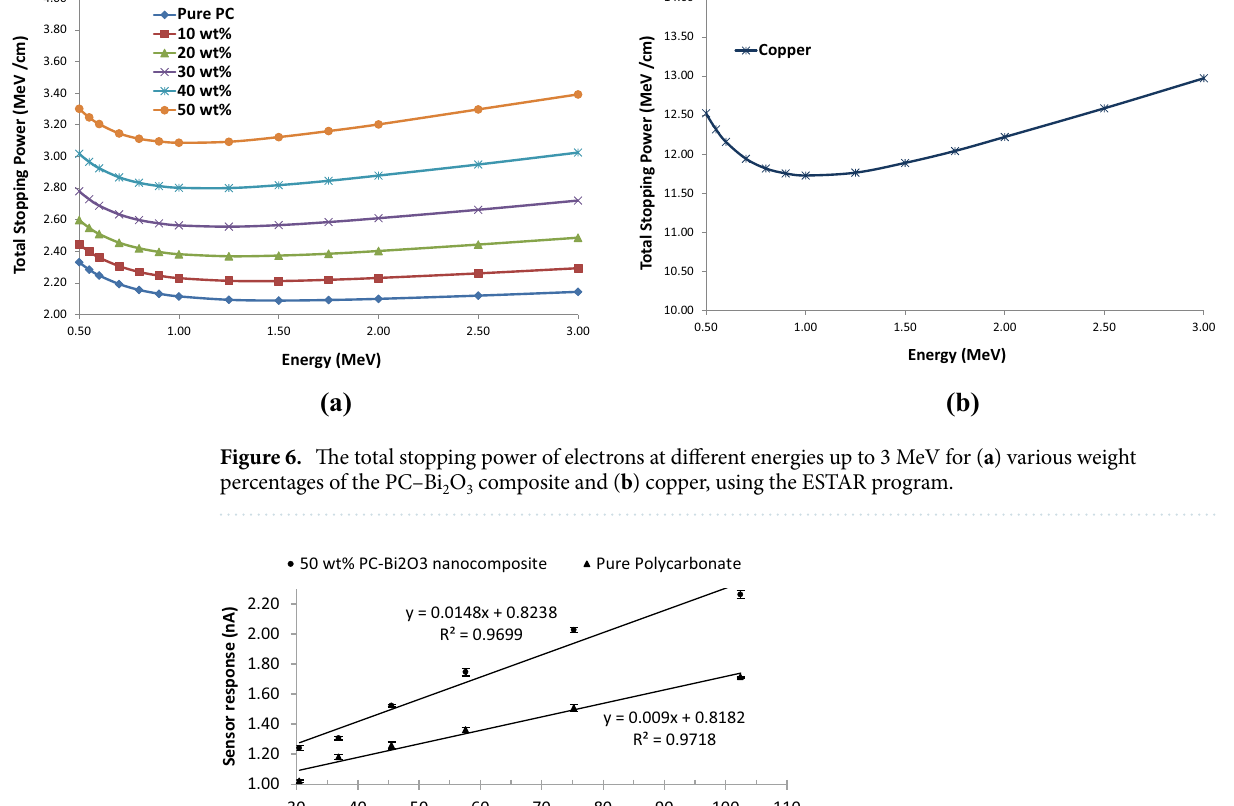
y = 0.009x + 0.8182 R² = 0.9718